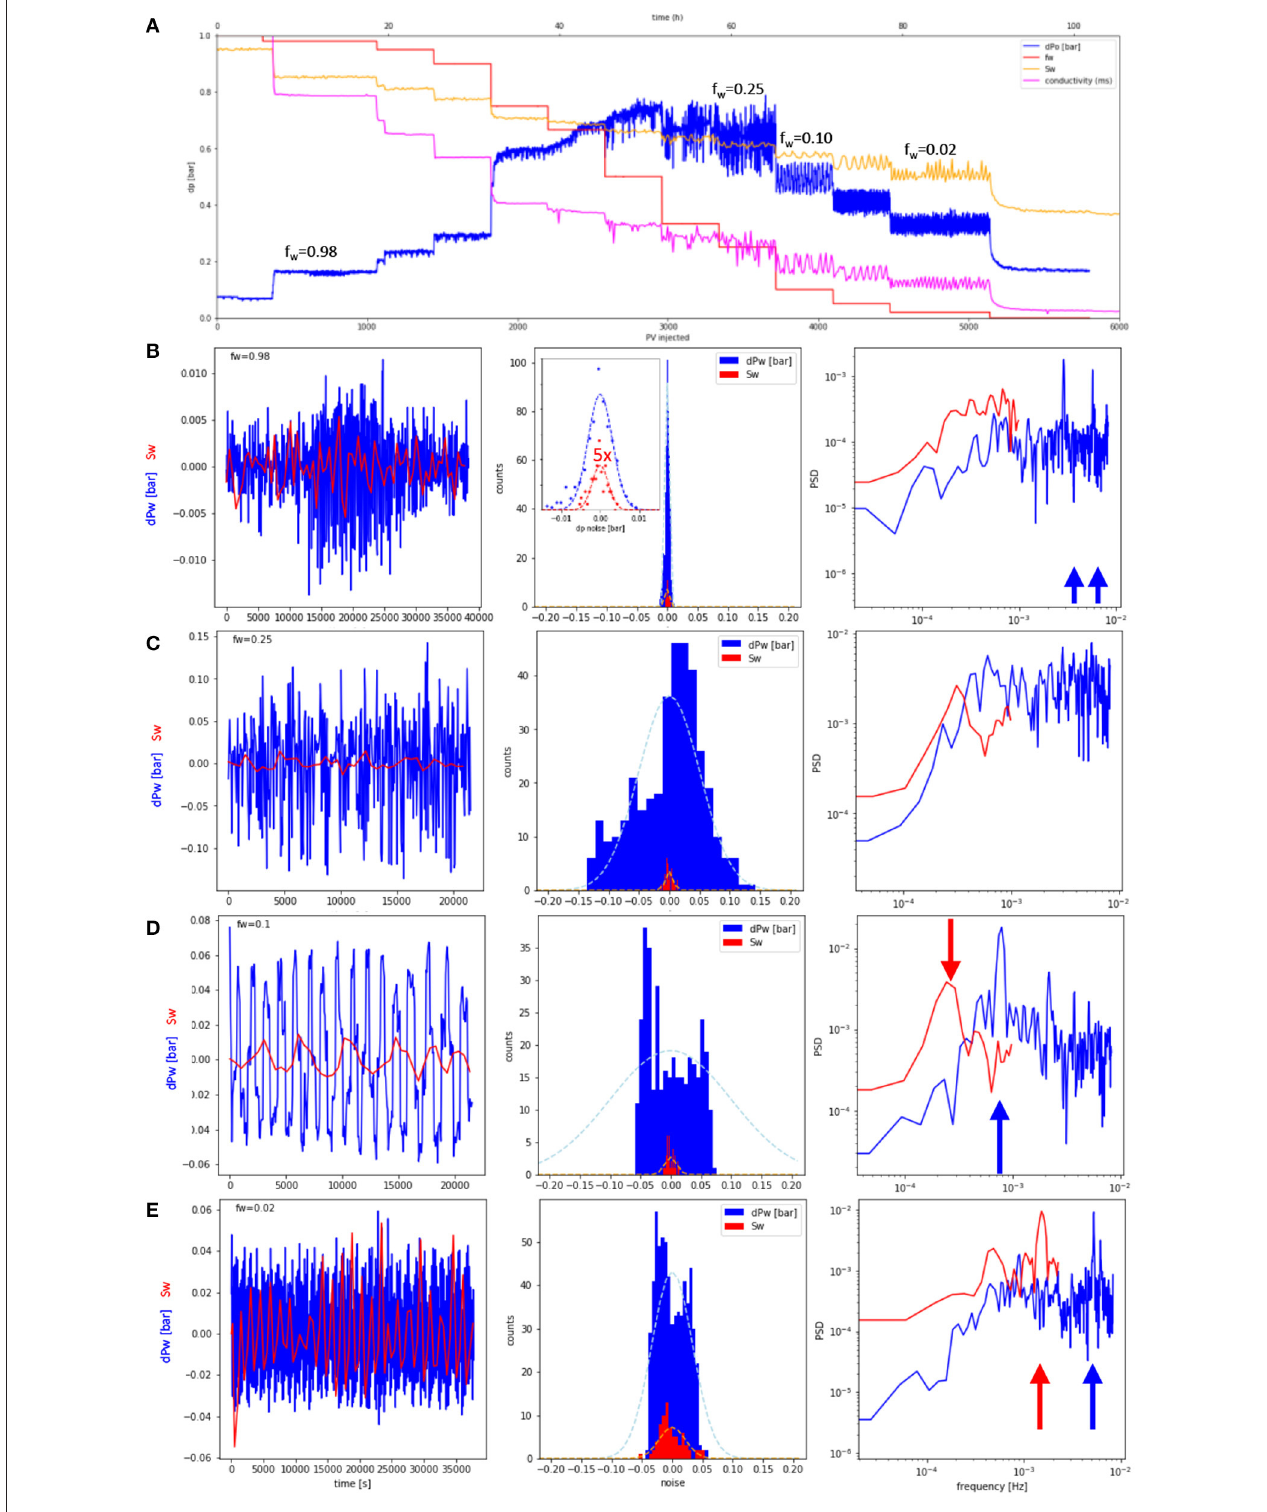
FIGURE 2 | Water pressure drop dP w , water saturation S w and electrical conductivity during a SCAL fractional flow experiment to determine relative permeability on a centimeter-sized Fontainebleau sandstone sample. Overview of the water pressure drop for all fractional flows f w (A) and fluctuations (with base line subtracted)